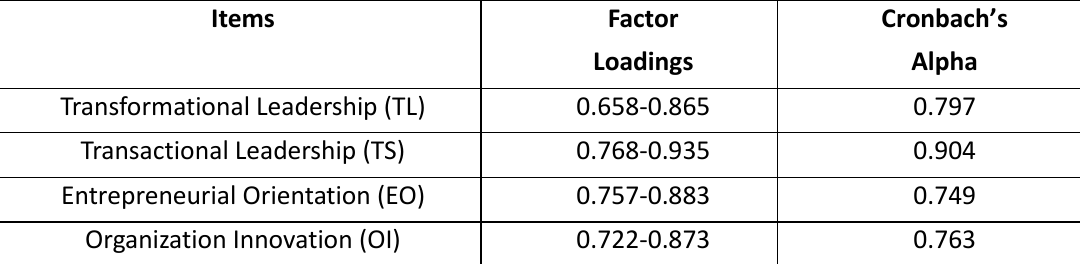
Results of Measure